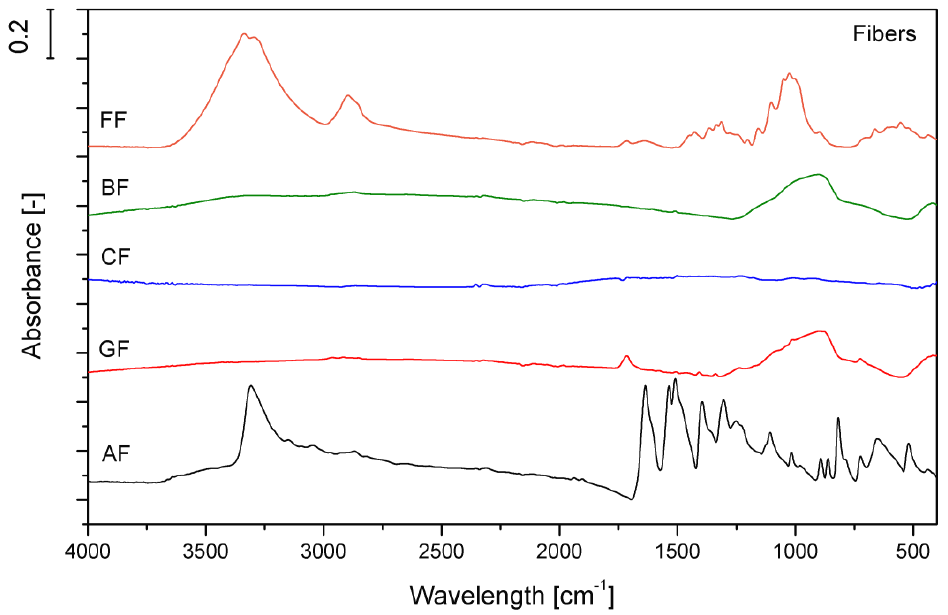
Figure 3. FTIR-ATR spectra of fibers used in the study.